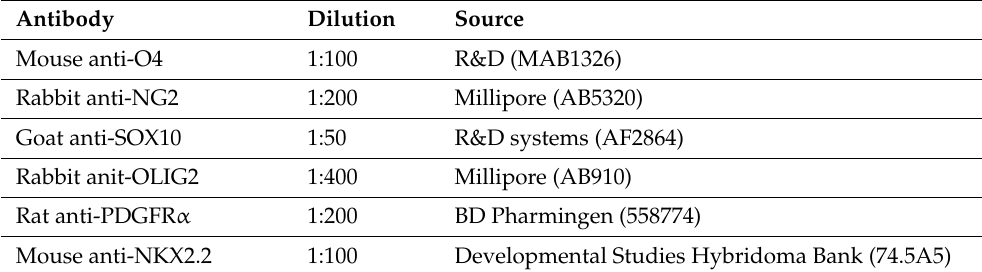
Table 2. List of primary antibodies used for in vitro cell